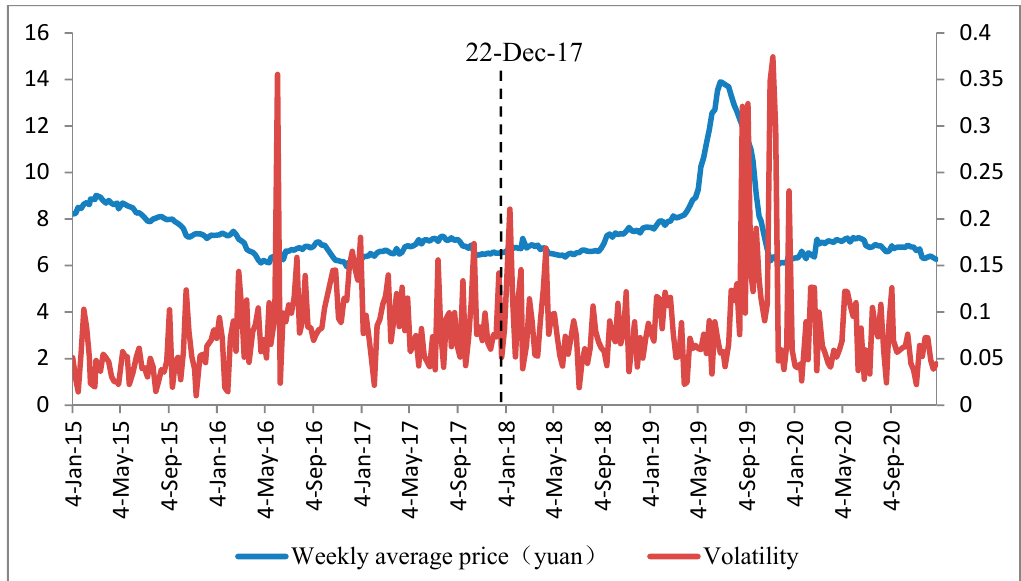
Figure 2 intuitively reflects the trend of the apple’s weekly average spot price and volatility during the six years from 2015 to 2020. Overall, the apple’s spot price and volatility were relatively stable before and after futurization, except for a significant rise and fall in 2019 (Figure 2). The highest price was about CNY 14 /kg, and then the price dropped sharply to about CNY 4.55/kg in 2019.